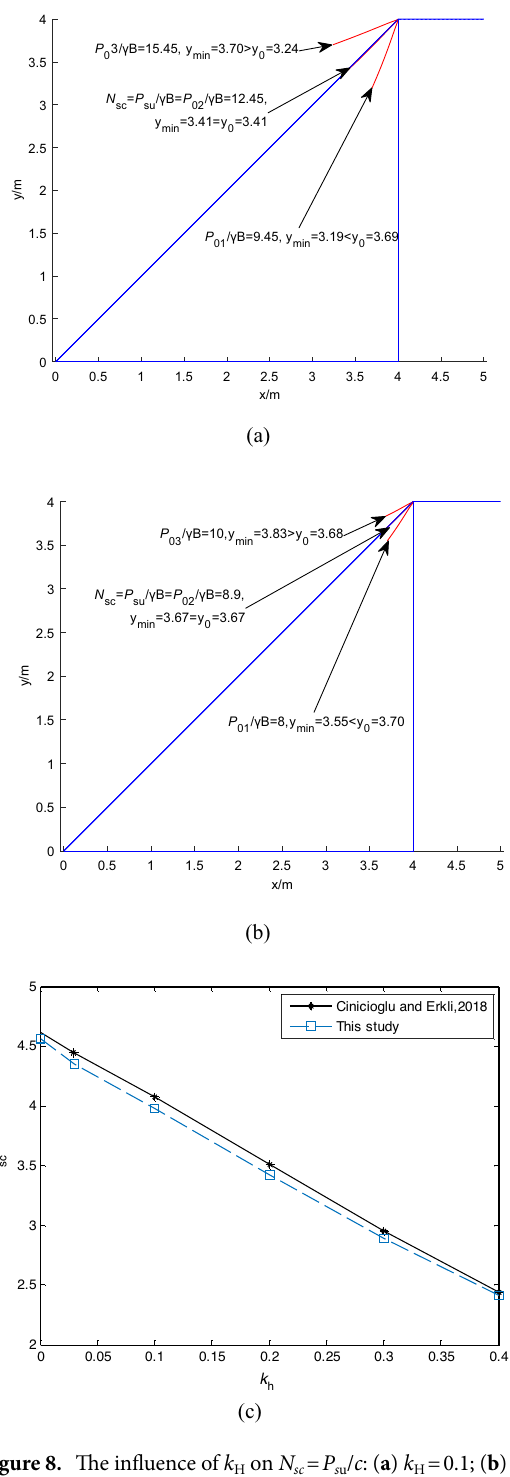
Figure 8. The influence of k H on N sc = P s u / c : ( a ) k H = 0.1; ( b ) k H = 0.35; ( c ) H/B = 1, 2, and 4; ( d ) α varying; (e) c/ γB